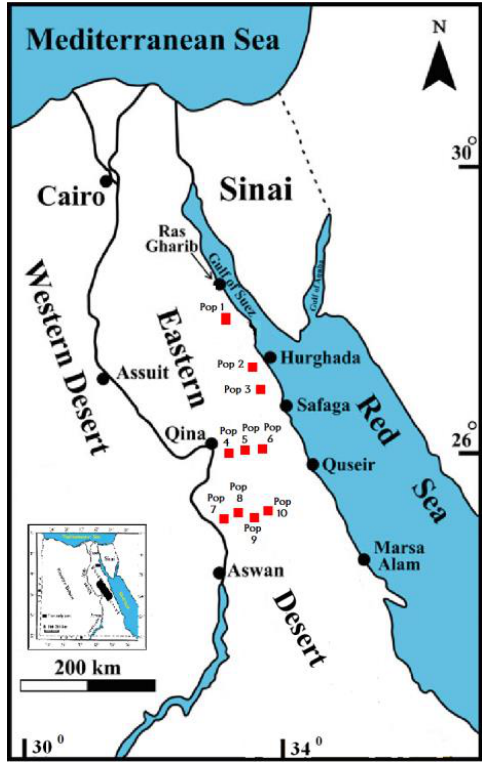
Figure 1. Map of Egypt showing the sites of populations of Aerva javanica used in this study. Location 1 = Ras Garib (Wadi Abo Had), Location 2 = Hurghada (Wadi Bali), Location 3 = Qena-Safaga Road (Wadi El-Markh), Location 4 = Qeft-Qusseir Road (Wadi El-Matulli), Location 5 = Qeft-Qusseir Road (Wadi El-Laqeita), Location 6 = Qeft-Qusseir Road (El Fawakher), Location 7 = Idfu-Mrsa Allam Road Wadi Abbady (Bir Abbady), Location 8 = Idfu-Mrsa Allam Road Wadi Abbady (El-Timsah), Location 9 = Idfu-Mrsa Allam Road Wadi Abbady (El-Kanayis), Location 10 = Idfu-Mrsa Allam Road Wadi Abbady (El-Kanayis).